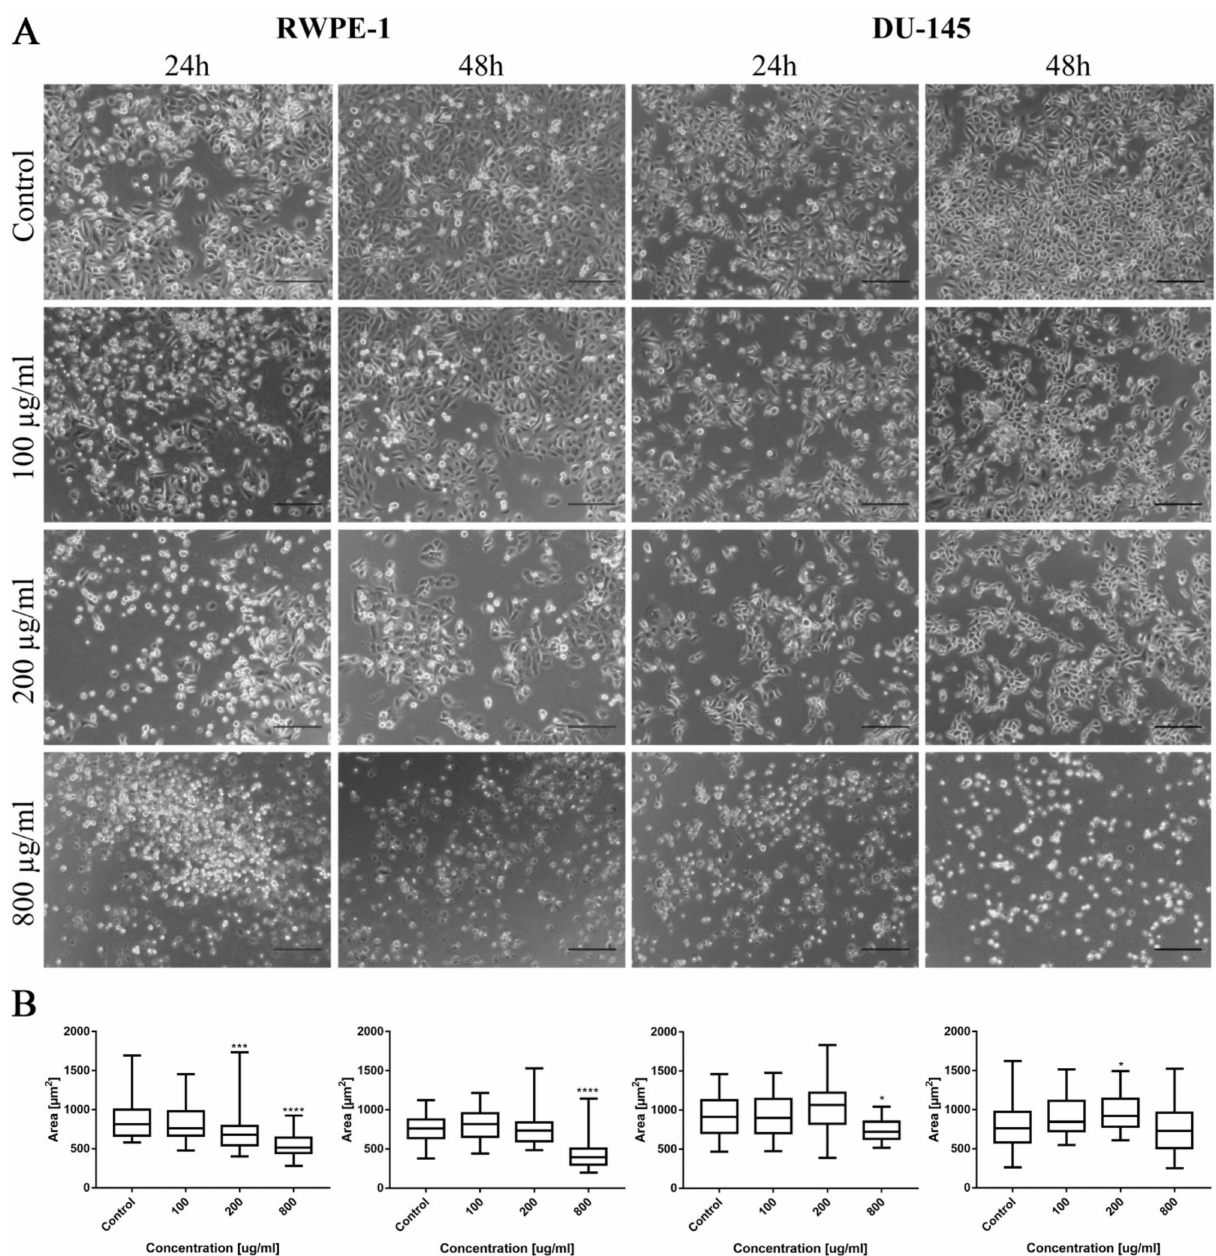
Figure 10. Prostate cell lines characteristic after levofloxacin treatment. ( A )—Morphology of prostate cell lines after lev- ofloxacin treatment. Cell shrinkage, rounding, and detachment were visible especially in higher levofloxacin concentrations. The addition of levofloxacin to cell culture did not cause crystals formation, which was observed using an inverted light microscope (bar = 200 µ m). ( B )—Morphometric analysis of cells area. DU-145—human prostate cancer; RWPE-1—non- malignant human prostate epithelium; statistically significant results compared to control were presented: *— p ≤ 0.05; ***— p ≤ 0.001; ****— p ≤